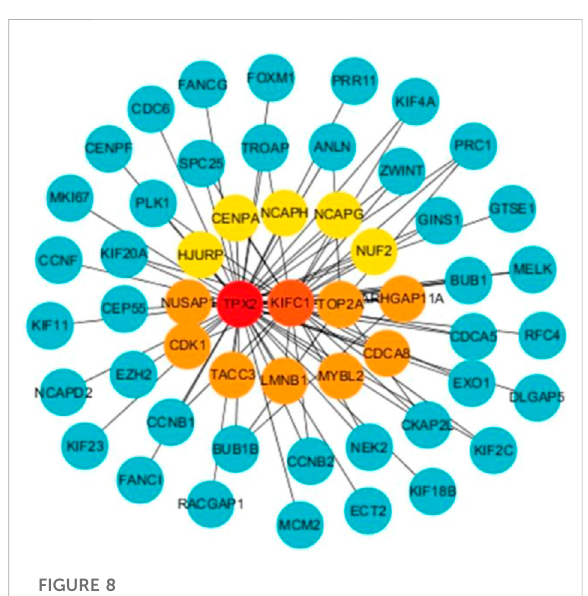
FIGURE 8 Network diagram of interaction between hub genes and candidate